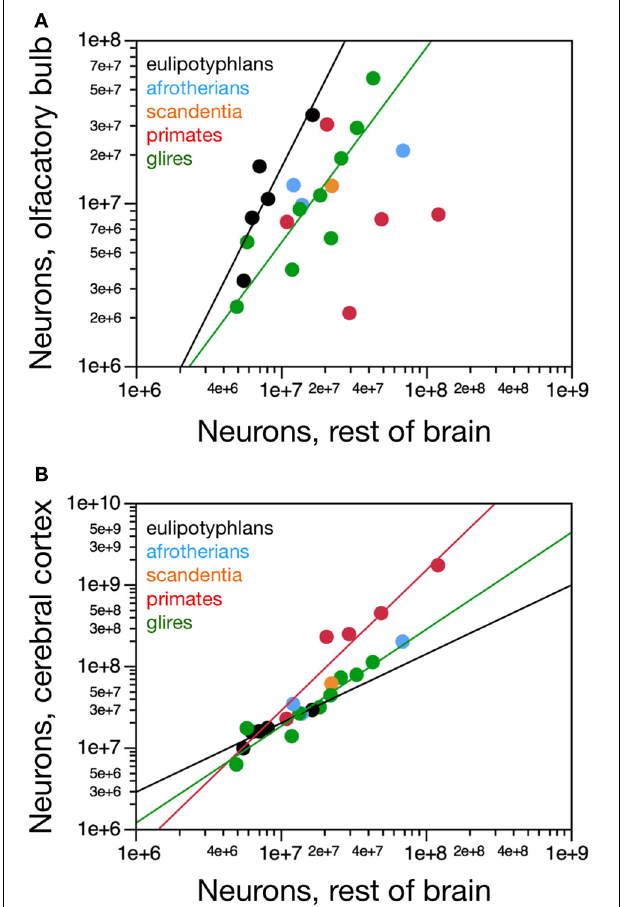
FIGURE 6 | Scaling of numbers of neurons in the olfactory bulb and in the cerebral cortex as a function of numbers of neurons in the rest of brain. (A) The number of neurons in the olfactory bulb increases as power functions of the number of neurons in the rest of brain of exponent 1.770 ± 0.578 in eulipotyphlans and 1.198 ± 0.252 in glires, respectively, but not in primates. Notice that eulipotyphlans have more neurons in the olfactory bulb than glires and afrotherians for similar numbers of rest of brain neurons. (B) The number of neurons in the cerebral cortex of eulipotyphlans increases more slowly than the number of neurons in the rest of brain, as a power function of exponent 0.846 ± 0.180, but at the same pace as the cerebral cortexinglires,withanexponentof1.018 ± 0.148.Noticethateulipotyphlans havemoreneuronsintheolfactorybulbthangliresandafrotheriansforsimilar numbers of cortical neurons. There is no significant relationship between numbers of olfactory bulb and cerebral cortical neurons across primate species. Eulipotyphlan data from Sarko et al. (2009). Afrotherian data from Neves et al. (2014). Glires, data from Herculano-Houzel et al. (2011) and this study. Primates and scandentia, data from this